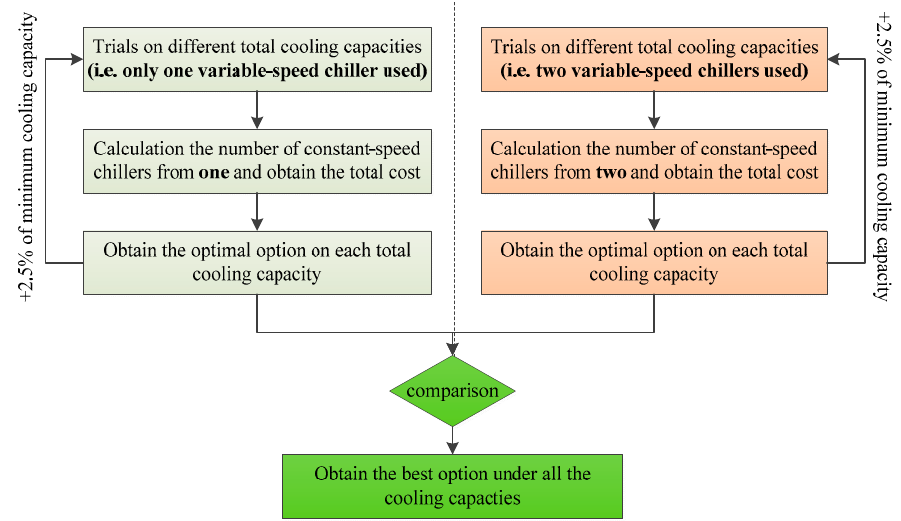
Figure 7. Trials of simulation to select optimum chiller plant design.